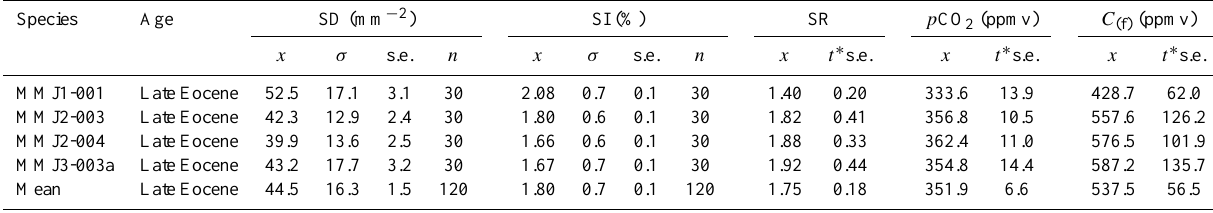
Table 6. Summary of stomatal parameters of the adaxial surface of fossil Nageia and p CO 2 [ C (f) ] estimates results. Species